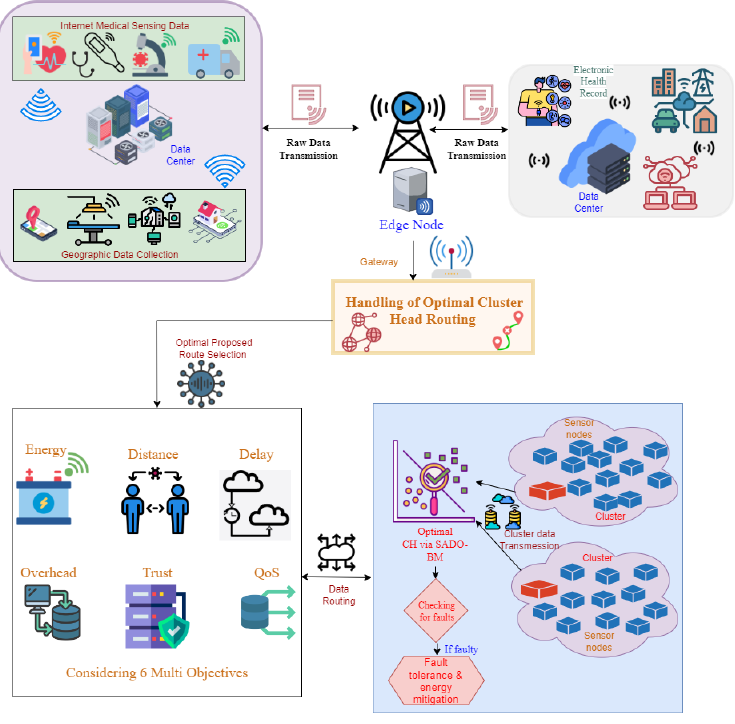
Figure 1. Representation of the proposed